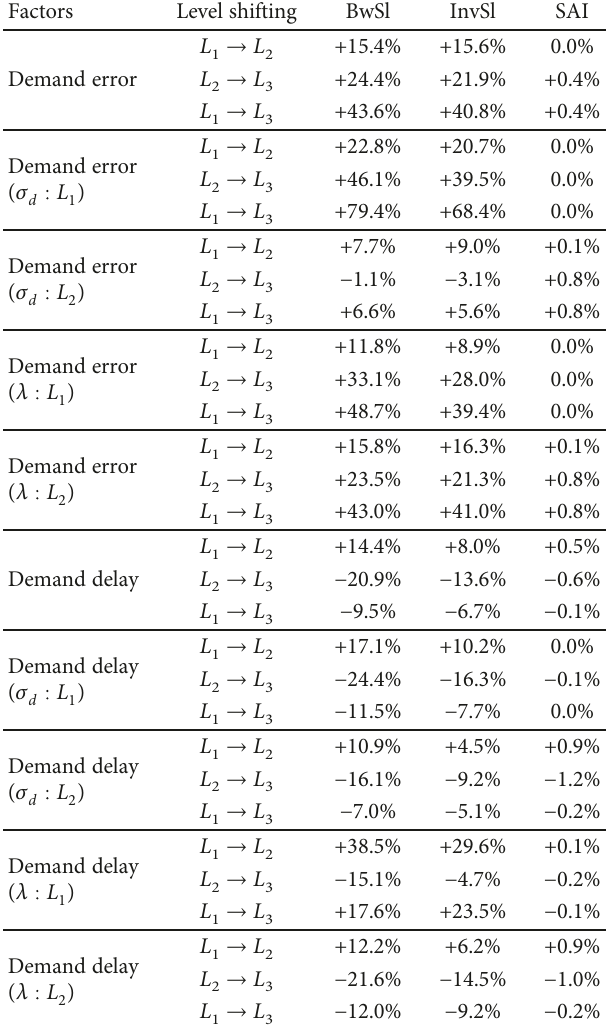
Table 9: Detailed percentual variations of main e ff ects and